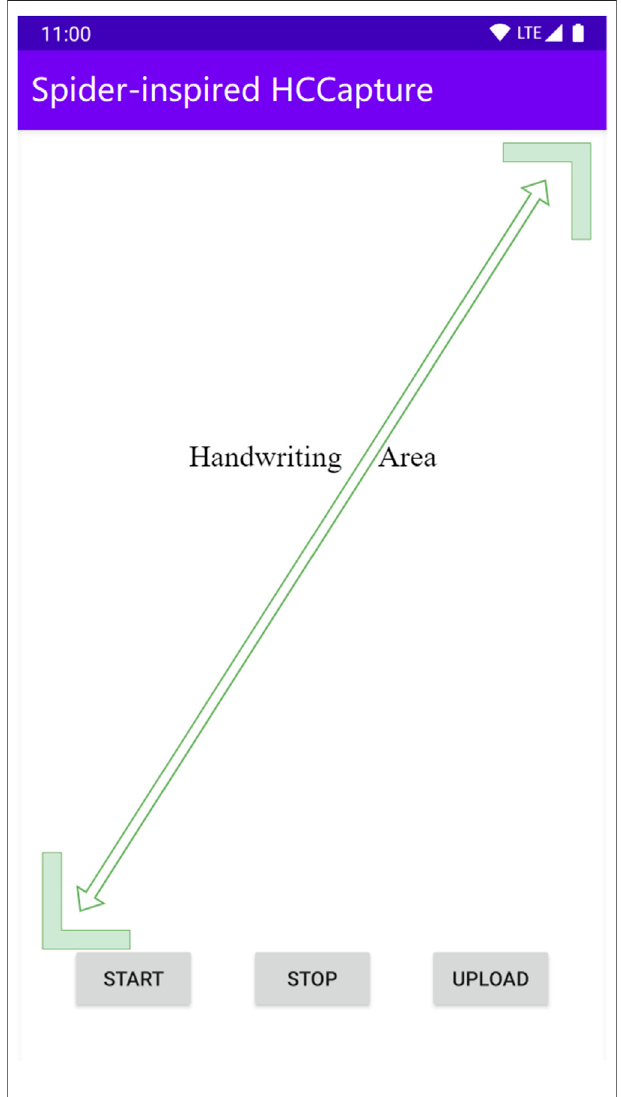
FIGURE 6 | Appearance of Spider-inspired HCCapture